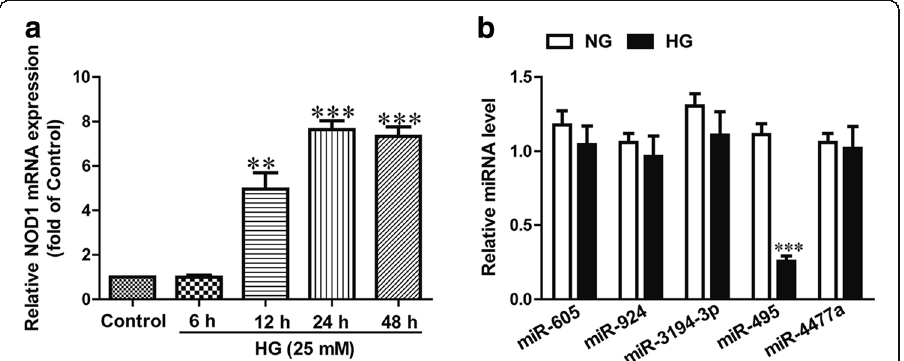
Fig. 1 The expressions of NOD1 and miR-495 in human CFs incubated with normal (5.5 mM) or high (25 mM) glucose for 6, 12, 24 or 48 h. a The mRNA expression of NOD1 was detected via quantitative RT-PCR. HG indicates CFs treated with 25 mM glucose for the indicated times. b The levels of miR-605, miR-924, miR-3194-3p, miR-495 and miR-4477a were determined via quantitative RT-PCR. The data shown are means ± SEM ( n = 6). NG indicates normal glucose, HG indicates high glucose, time in all cases was 24 h. ** p < 0.01, *** p < 0.001 vs. control or normal